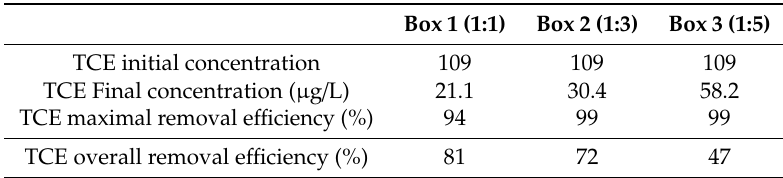
Table 3. Final concentrations and removal efficiency of TCE .